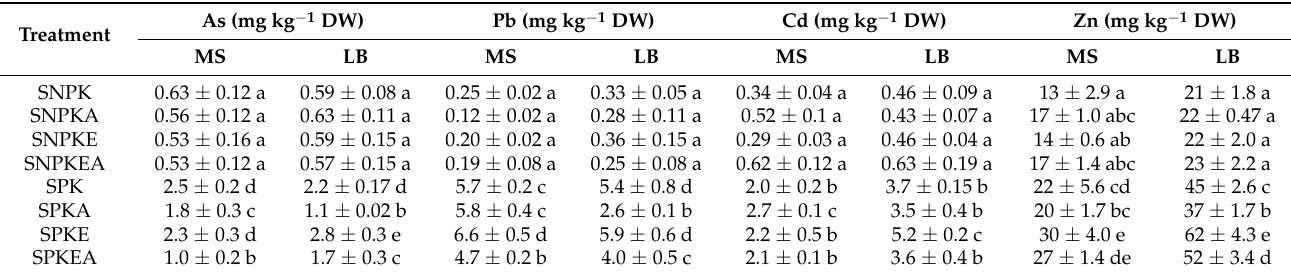
Table 4. Total concentration (mg kg − 1 DW) of heavy metal (As, Pb, Cd, and Zn) in stem (MS: main stem; LB: lateral branch) of K. pentacarpos exposed to non-polluted or polluted soil in the presence or in the absence of NaCl or/and EDDS for five months. Each value is the mean of 3 replicates and vertical bars are S.E. Values exhibiting different letters are significantly different at p < 0.05 according to SNK test.